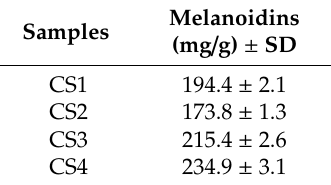
Table 1. Melanoidin content in di ff erent analyzed co ff ee silverskin (CS)